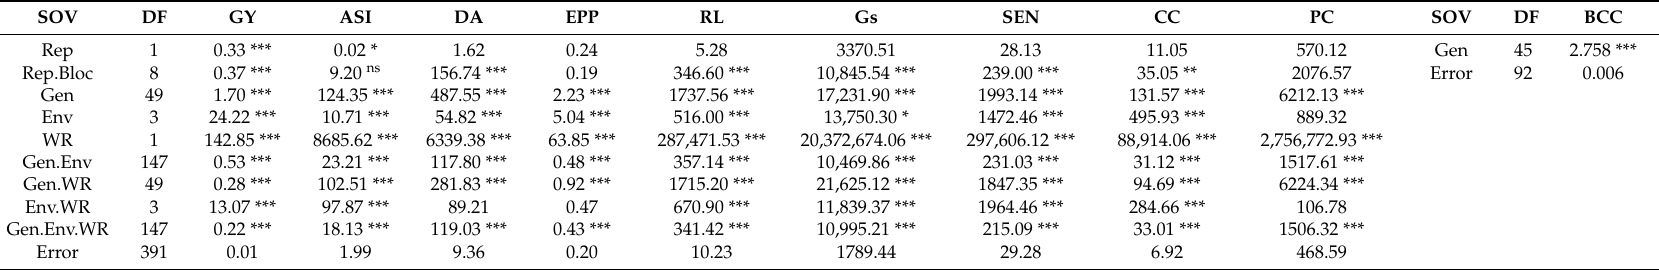
Table 1. Mean squares and significant tests after combined analysis of variance for nine morphophysiological traits of 50 inbred